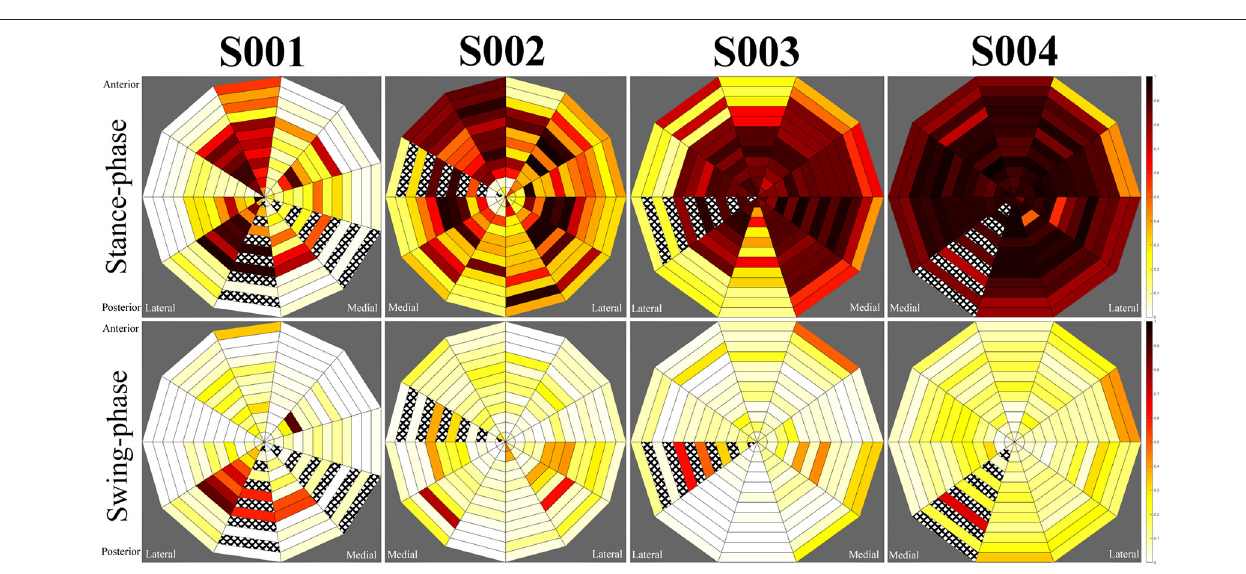
FIGURE 5 | Average central step pressure maps for each subject. Top row: stance phase, bottom row: swing-phase.